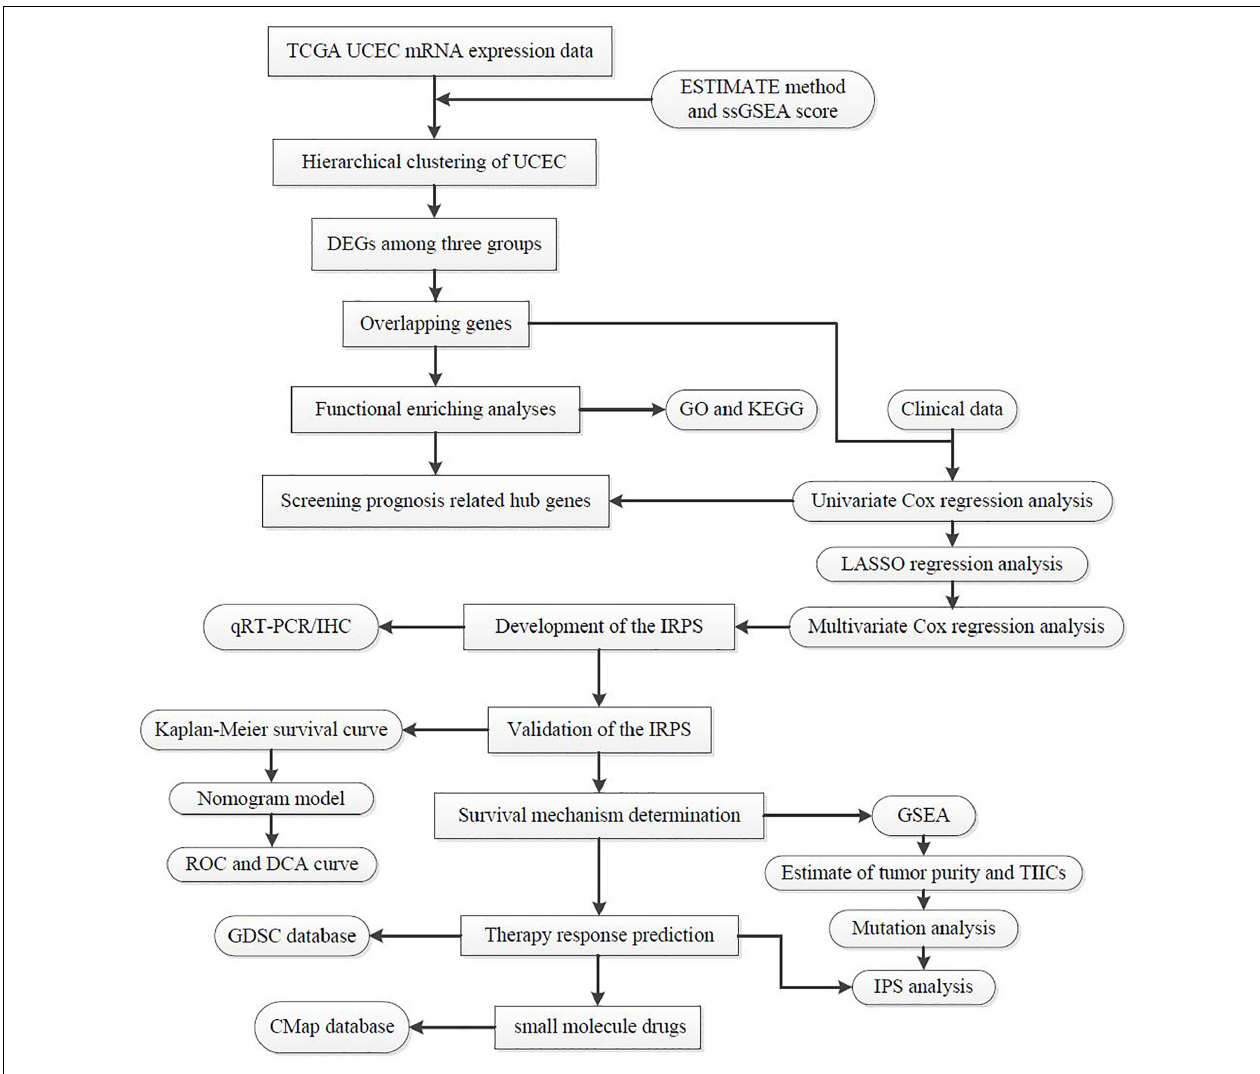
FIGURE 1 | The workflow employed to identify small molecular drug targets for patients with high IRPS.